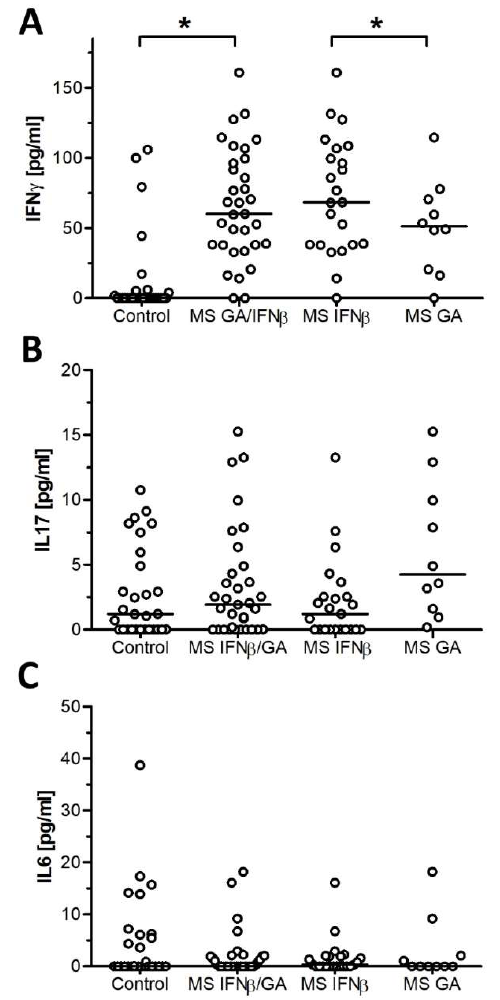
Figure 3. Cytokine concentrations in MS patients and healthy subjects. Cytokines were determined using ELISA MAX Deluxe kits (BioLegend). The results show the values of all subjects belonging to each group. The line represents the median of each cytokine in pg / mL. Significant di ff erences were assessed using the Mann Whitney U test, (*) means p < 0.05. ( A ) IFN- γ , ( B ) IL17, ( C ) IL6.